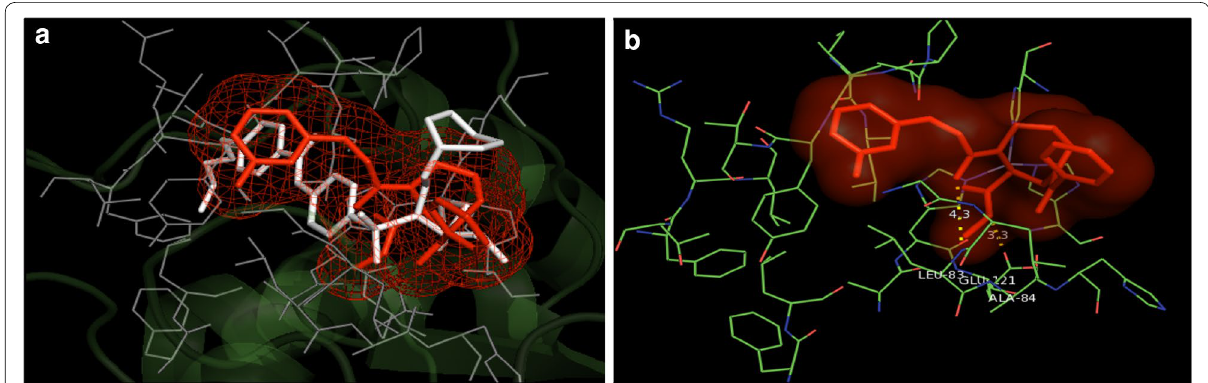
Fig. 4 a Overlay of the docked pose of compound 7 (red) with that of PDB Ligand 1HOV (white); b docked pose: H-bond interaction of compound 7 in the binding site of MMP-2 protein